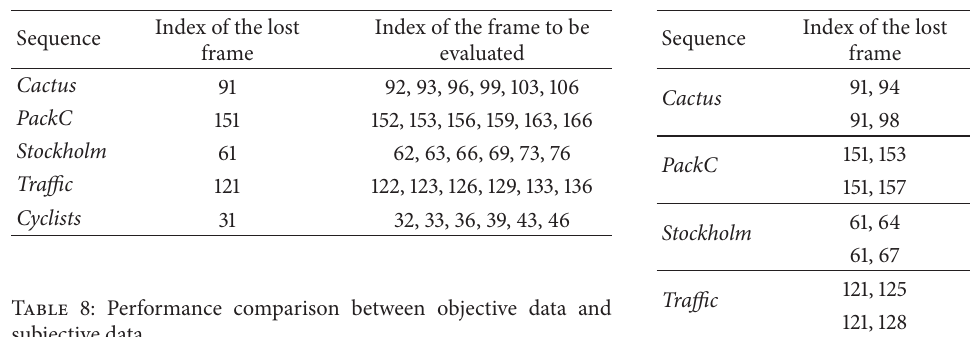
Table 7: Lost frame index of each sequence.